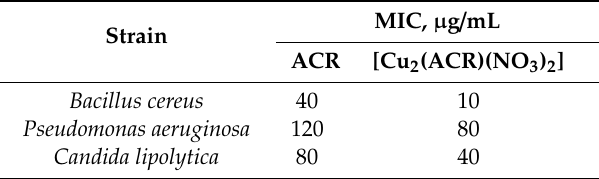
Table 2. Minimum inhibitory concentration (MIC) values of the compounds ACR and [Cu 2 (ACR)(NO 3 ) 2 ] towards the tested strains. MIC, µg/mL Strain ACR [Cu 2 (ACR)(NO 3 ) 2 ] Bacillus cereus 40 10 Pseudomonas aeruginosa 120 80 Candida lipolytica 80 40